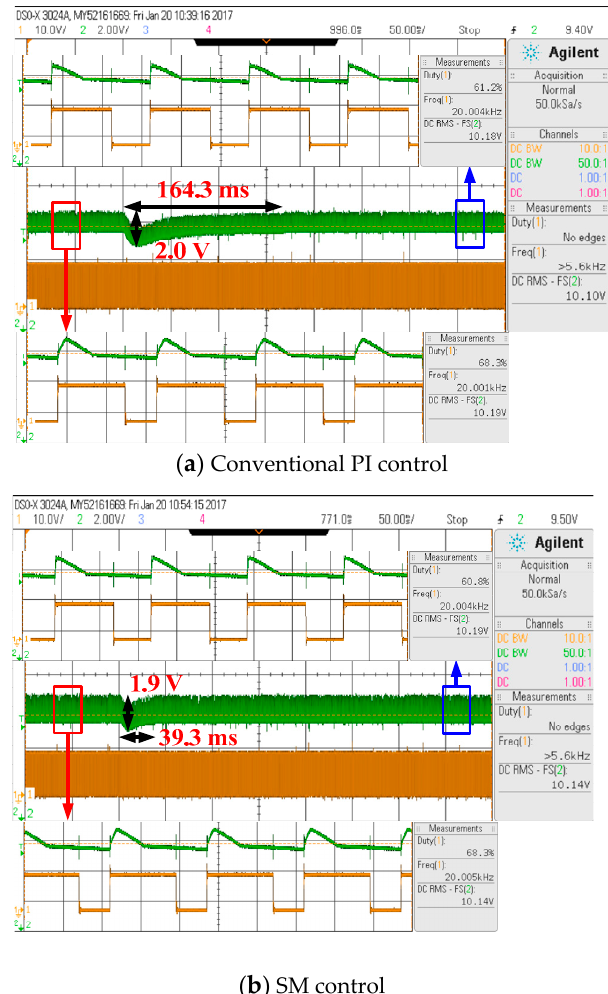
Figure 8. The waveforms of V out and the switching signals when the phase displacement is altered from 120° to 100°.